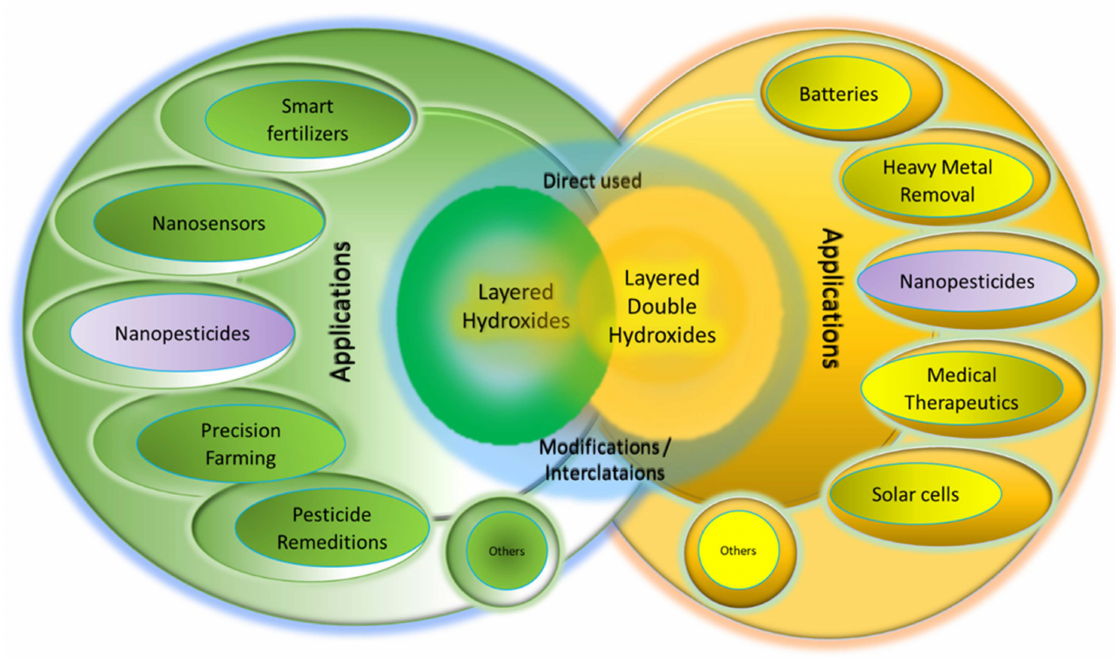
Figure 2. Various technological applications of LHs and LDHs either as they are or after modification by intercalation of AIs using the host–guest supramolecular chemistry